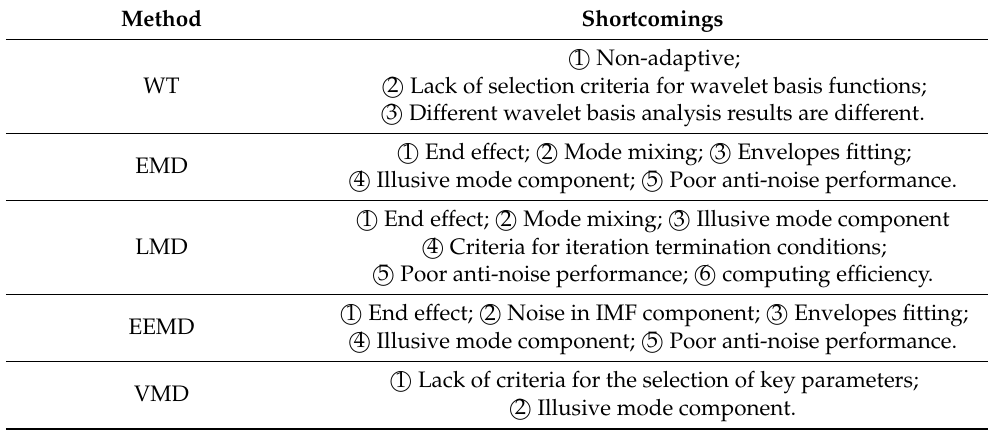
Table 1. The characteristics of common signal decomposition